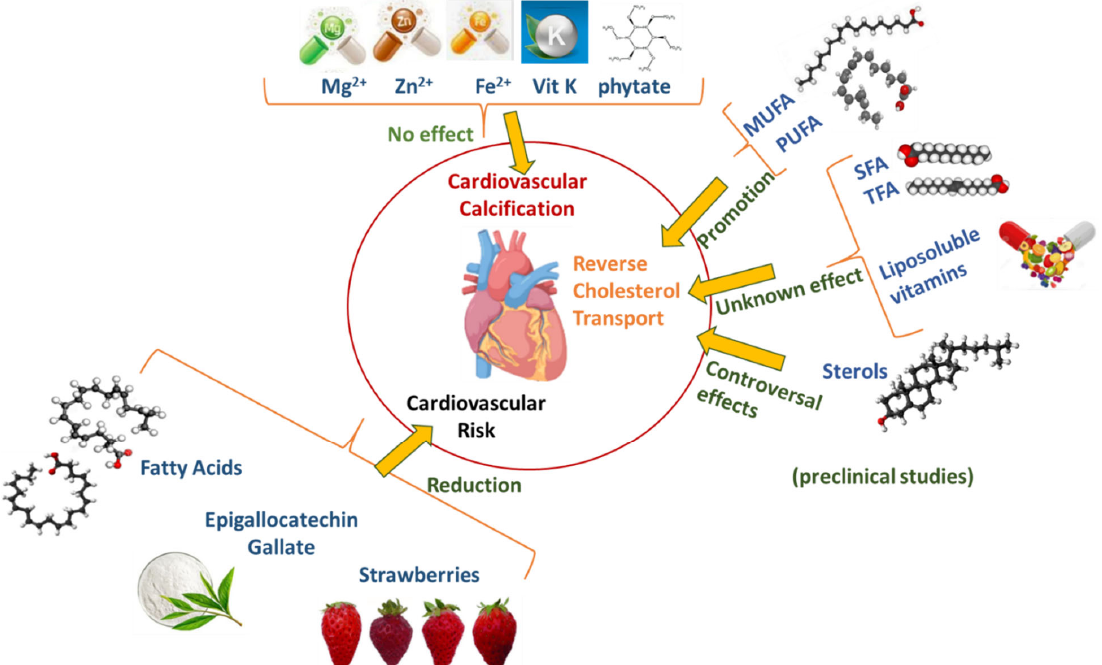
Figure 1. Effects of nutritional interventions on CV risk and related risk factors. Strawberry intake exerted positive cardiometabolic effect by improving insulin sensitivity in obese patients; ECGC determined a significant decrease in CV risk in patients with multiple sclerosis; emerging experimental evidence documented differential positive effects of dietary fatty acids, sterols and liposoluble vitamins on reverse cholesterol transport (RCT); supplementation with nutraceuticals, i.e., magnesium, zinc, iron, vitamin K, and phytate, has been studied for the effects on the progression of vascular calcification however no conclusive data have been obtained yet; dietary fatty acids intake had positive effects on CV risk. Abbreviations: Mg 2+ , magnesium; Zn 2+ , zinc, Fe 3+ , iron, Vit K, vitamin K; MUFA, monoinsaturated faccty acids; PUFA, polyinsaturated fatty acids; SFA, saturated fatty acids; TFA, trans fatty acids; ECGC, epigallocatechin gallate.